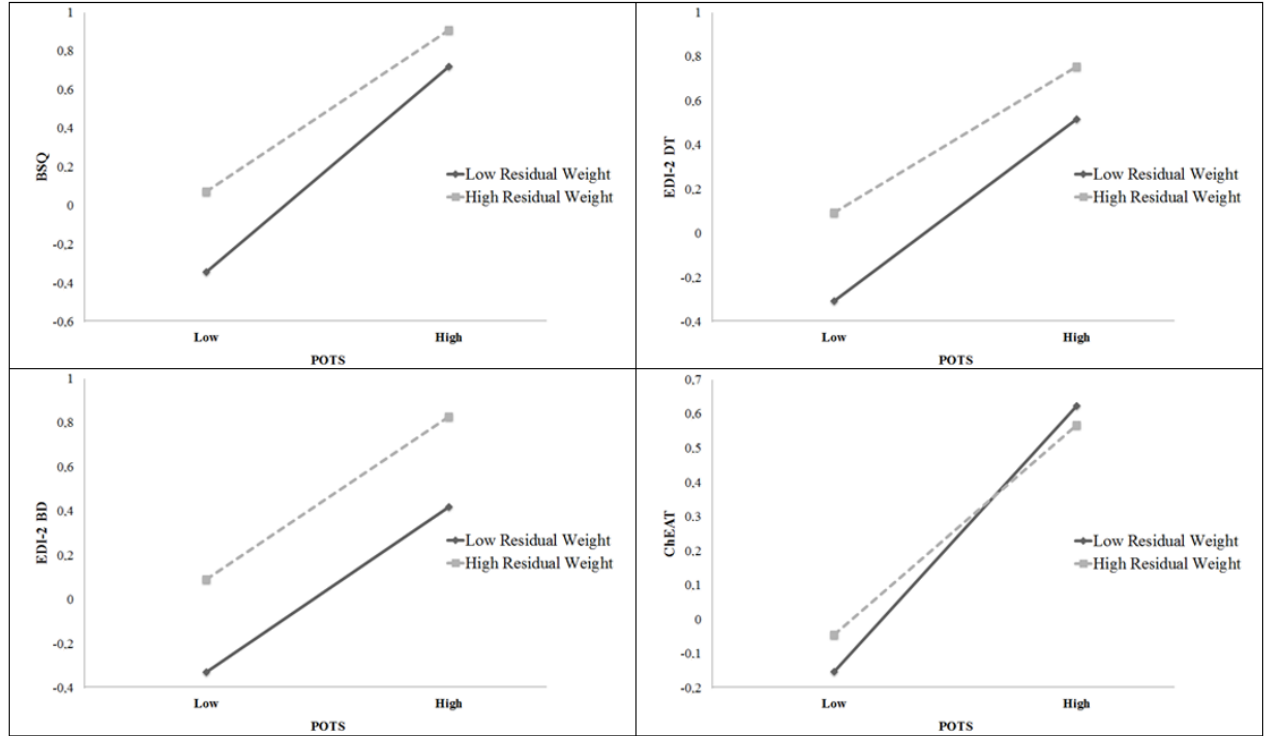
Figure 1. Interaction between residual weight and POTS-WT in predicting BSQ, EDI-2 DT, EDI-2 BD and ChEAT in adolescents.